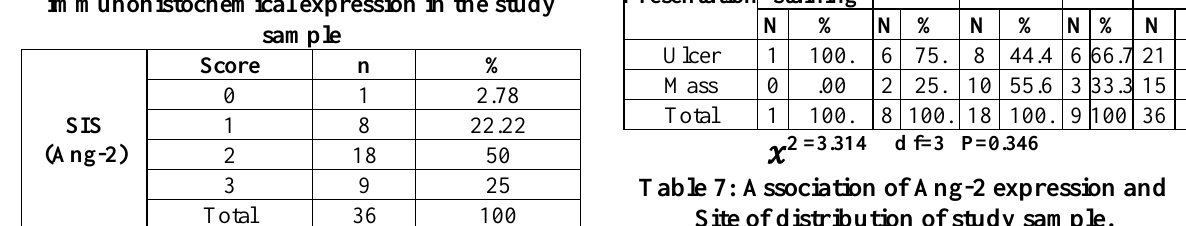
Table 3: SIS of Ang-2 antibody